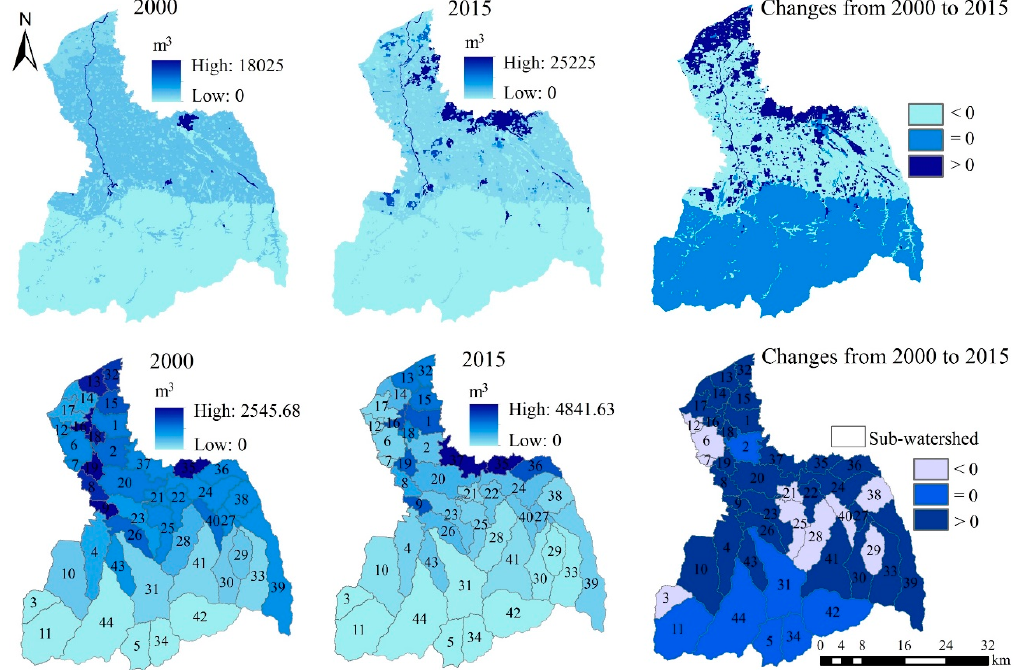
Figure 9. The spatial distribution and spatial–temporal changes of fresh water demand.